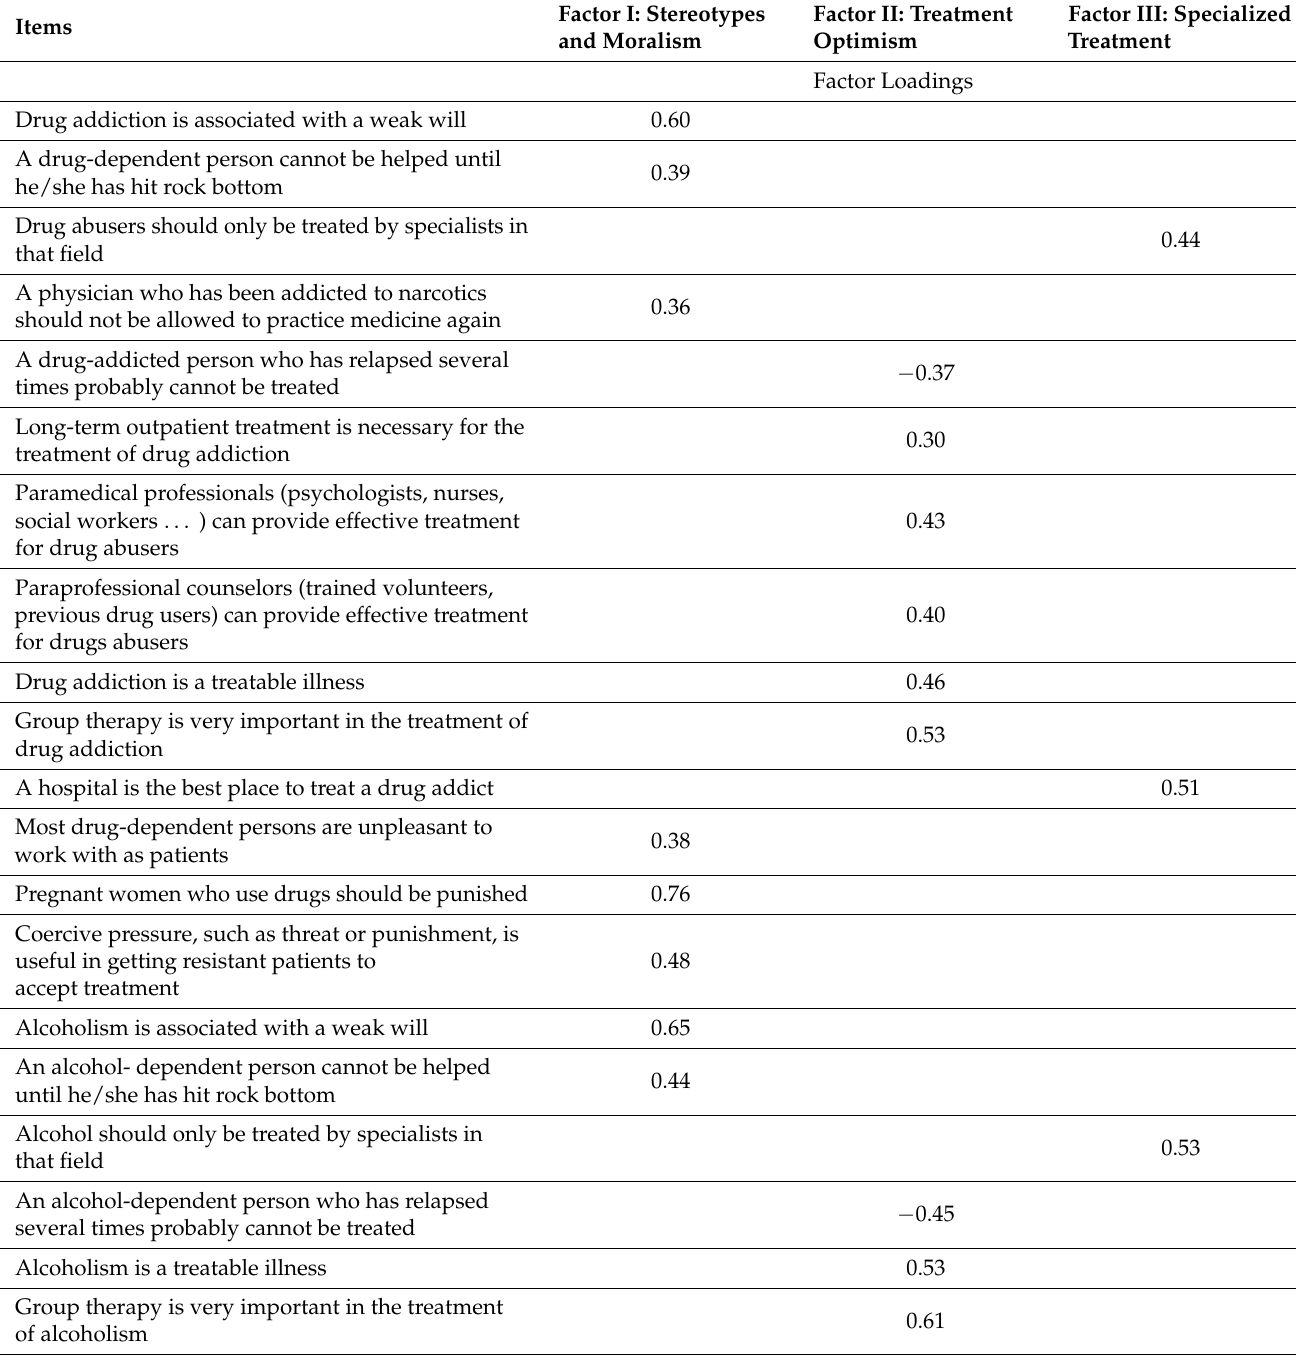
Table 1. beSAAS: factors, factor loadings, Cronbach’s alpha, eigenvalues and explained